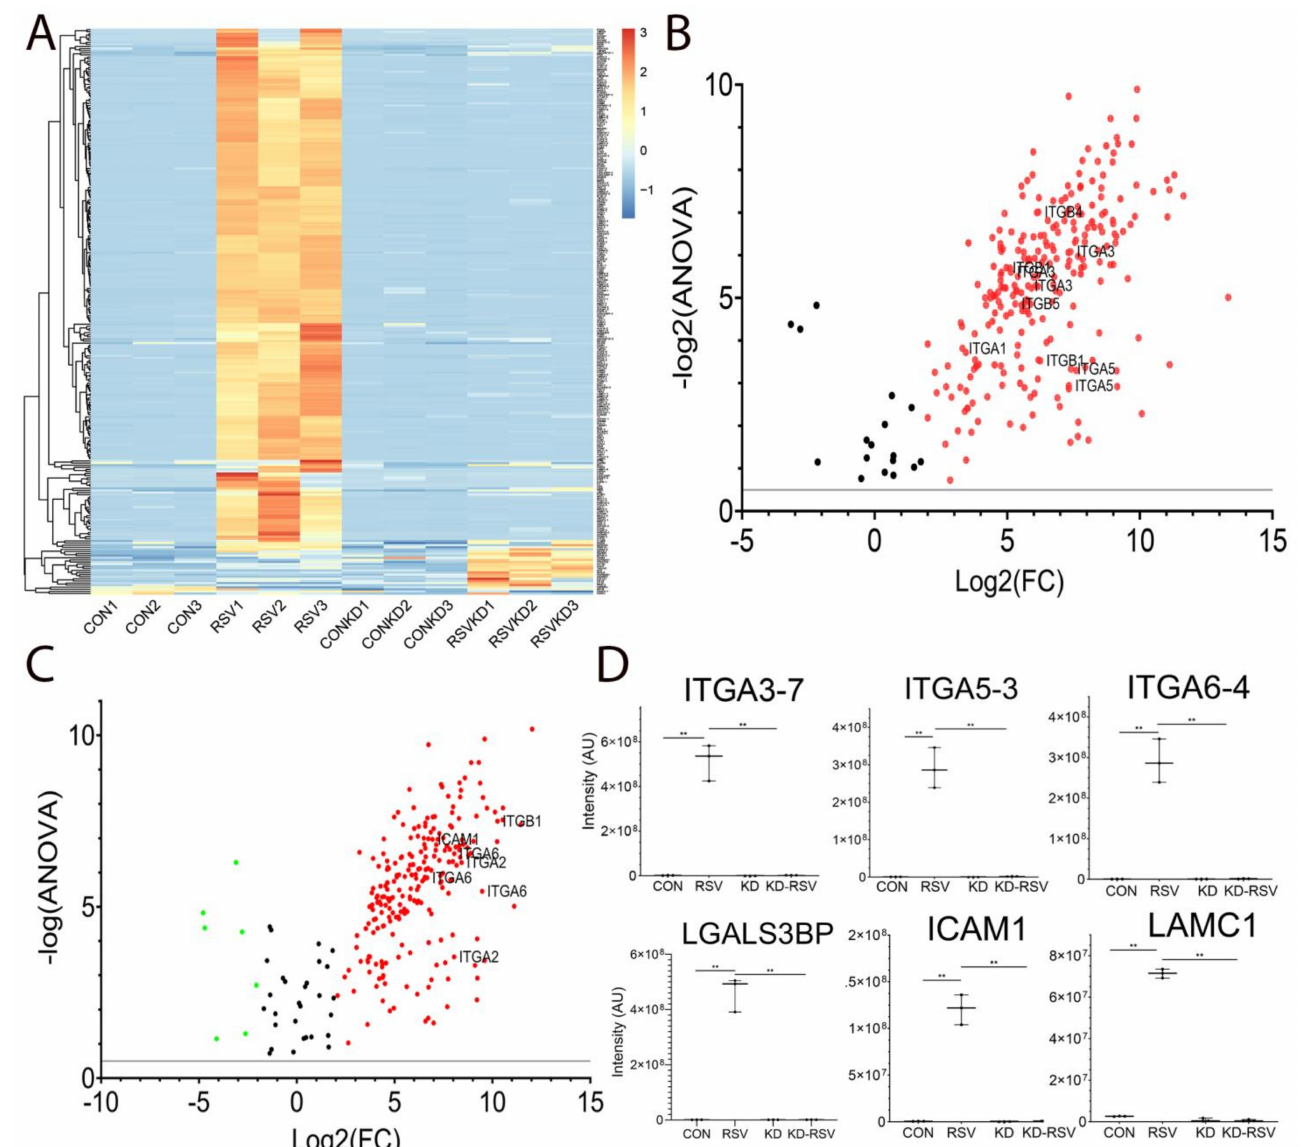
Figure 2. RSV and RELA regulate intracellular N-glycosylation of the integrin signaling pathway. N-glycoproteins were identified in cytoplasmic proteins from control and RSV-infected cells in the presence or absence of RELA silencing. ( A ) Agglomerative hierarchical clustering of 171 peptides significantly changed across the treatment conditions. Data was Z-scored across the row prior to clustering using Euclidian distance. The legend is at right. Each row represents an individual peptide; columns refer to different cell treatments/conditions. Note that the replicates for each treatment group cluster together and that the bulk of the N-glycopeptides are induced by RSV infection and are not observed in the RELA-depleted cells. ( B ) Volcano plot of peptides in RSV- versus mock-treated samples. X axis, fold change RSV versus mock; Y axis, log2 (ANOVA). Selected peptides in the integrin signaling pathway are labeled. ( C ) Volcano plot of peptides in RSV-infected cells WT versus RELA knockdown samples. X axis, fold change RSV versus mock; Y axis, log2 (ANOVA). Selected peptides in the integrin signaling pathway are labeled. ( D ) LFQ intensity for selected integrin (ITG), galectin-3 binding protein (LGALS3BP), ICAM1 and laminin subunit gamma 1 (LAMC1) peptides. **, p < 0.01